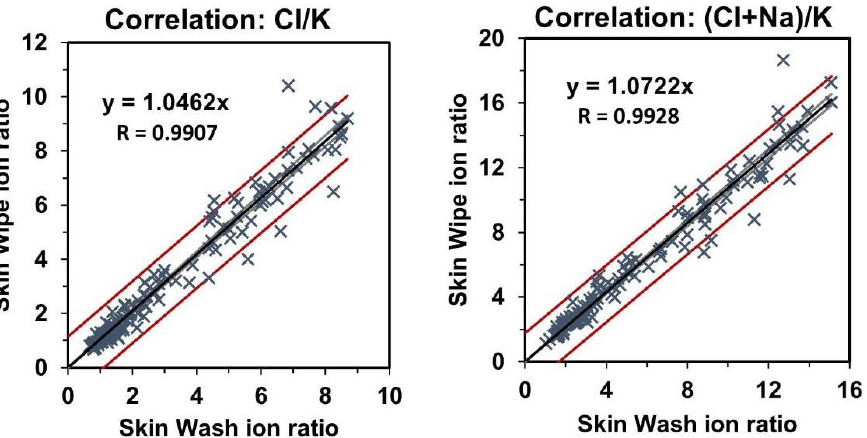
Figure 6. Correlation of data obtained from skin-wash and skin-wipe methods. The black line is the regression line, grey lines define the confidence interval, and red lines define the prediction band.